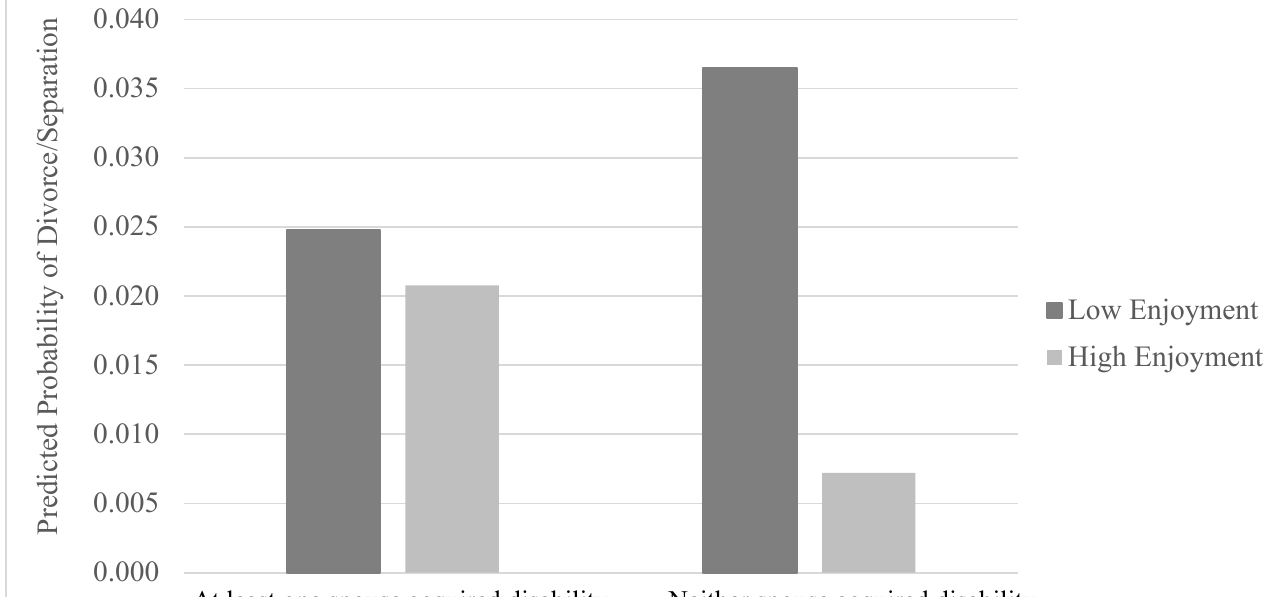
Figure 1. Predicted Probabilities of Divorce/Separation by Couple-Level Acquired Disability and Marital Quality. Notes: All covariates are set to sample mean.